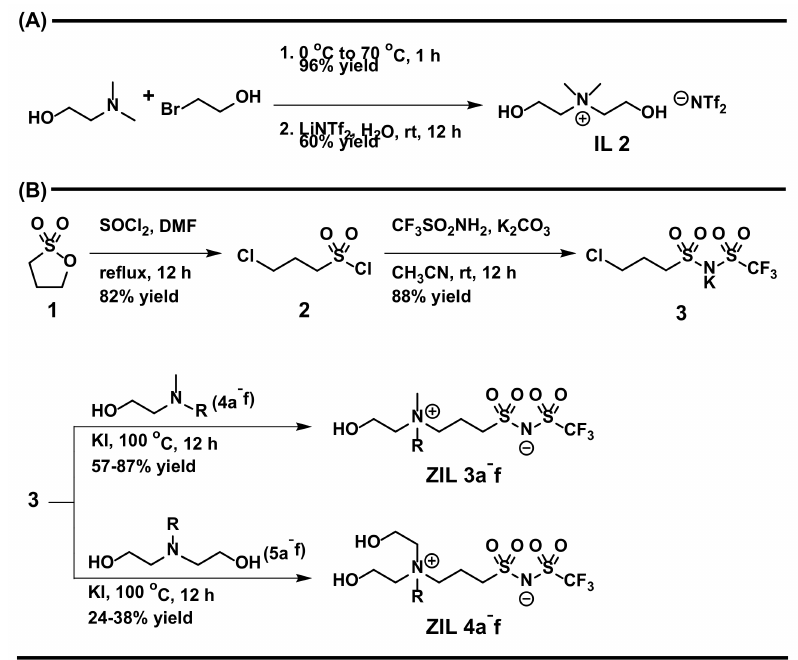
Figure 2. Synthesis of ( A ) IL 2 and ( B ) ZIL 3a–f and ZIL 4a–f ionic